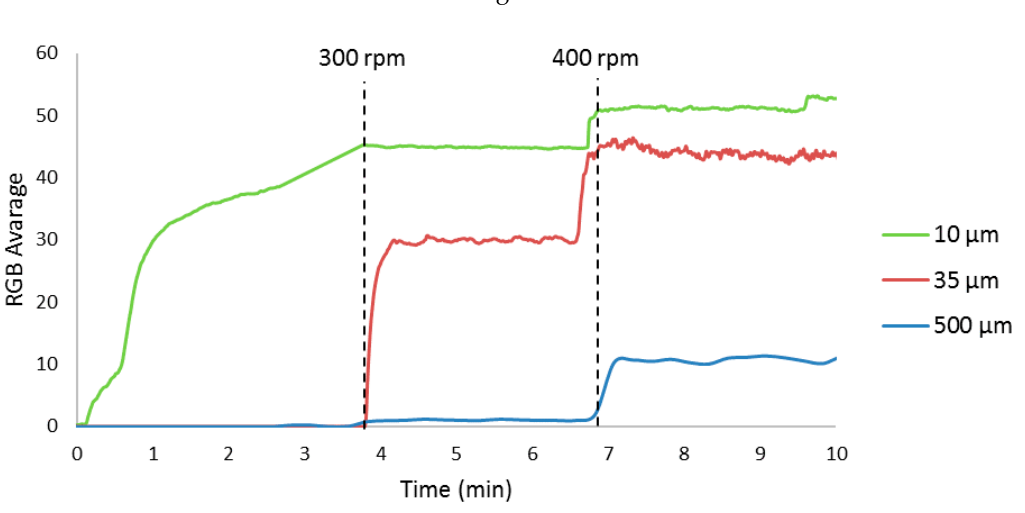
Figure 2. RGB averages of 0.1000 g of particles with three different sizes at 300 rpm (starts close to 4 min) and 400 rpm (starts close to 7 min).